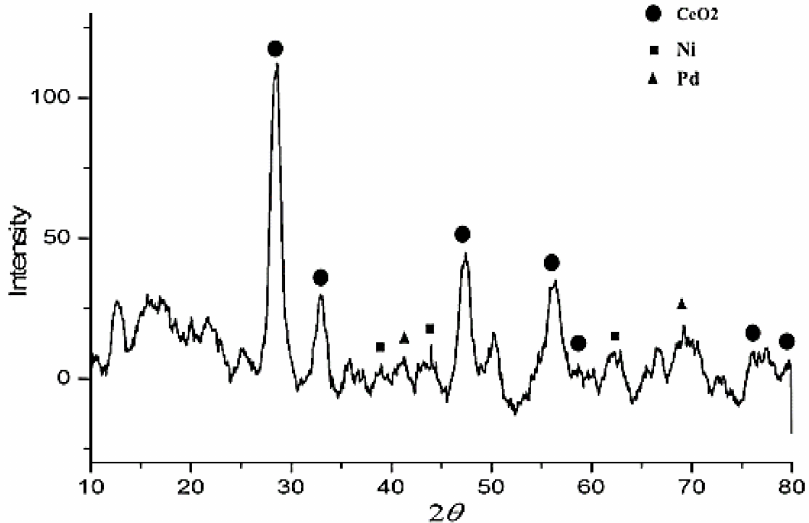
Figure 4. Powder X-ray diffraction of Pd-Ni/AC-CeO 2